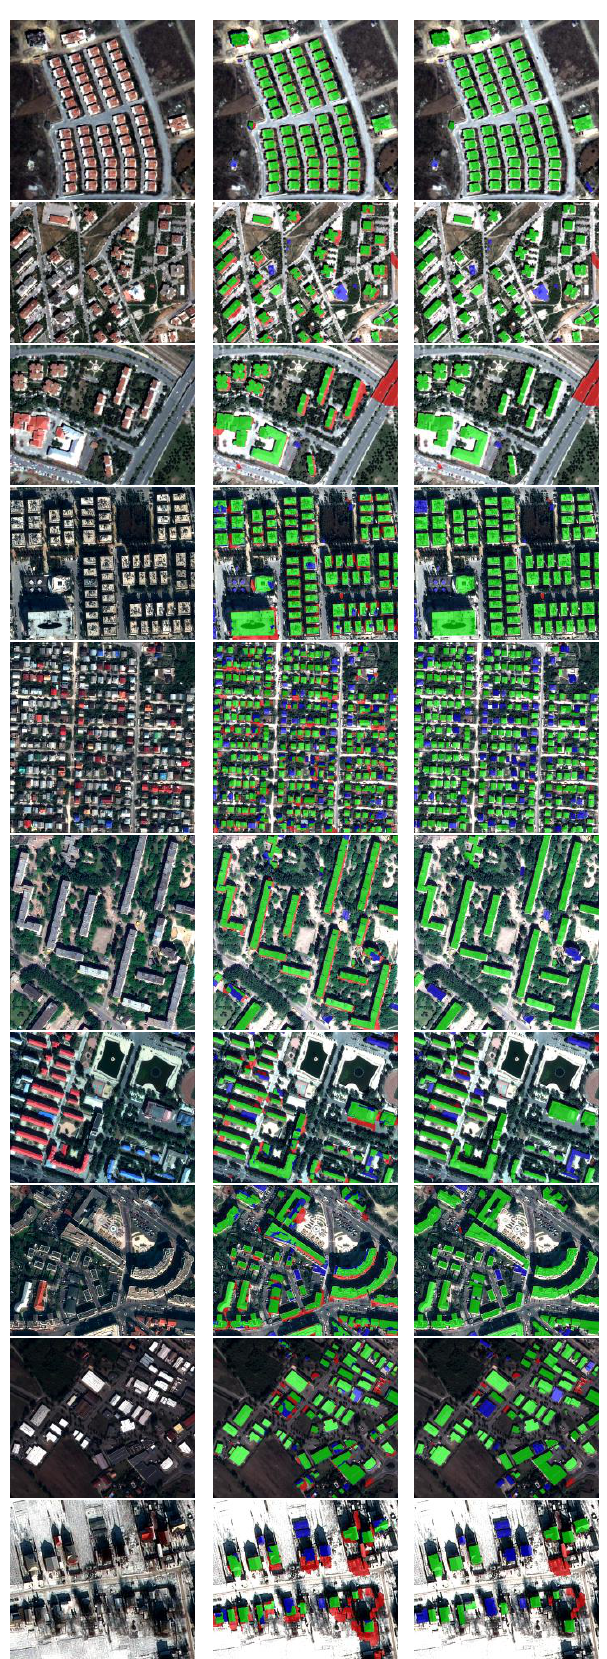
Figure 5. (first column) Test dataset (#1-10), (second column) the results of per-pixel evaluation, and (third column) the results of per-object evaluation. Green, red and blue colours represent true-positive, false-positive and false-negative, respectively.